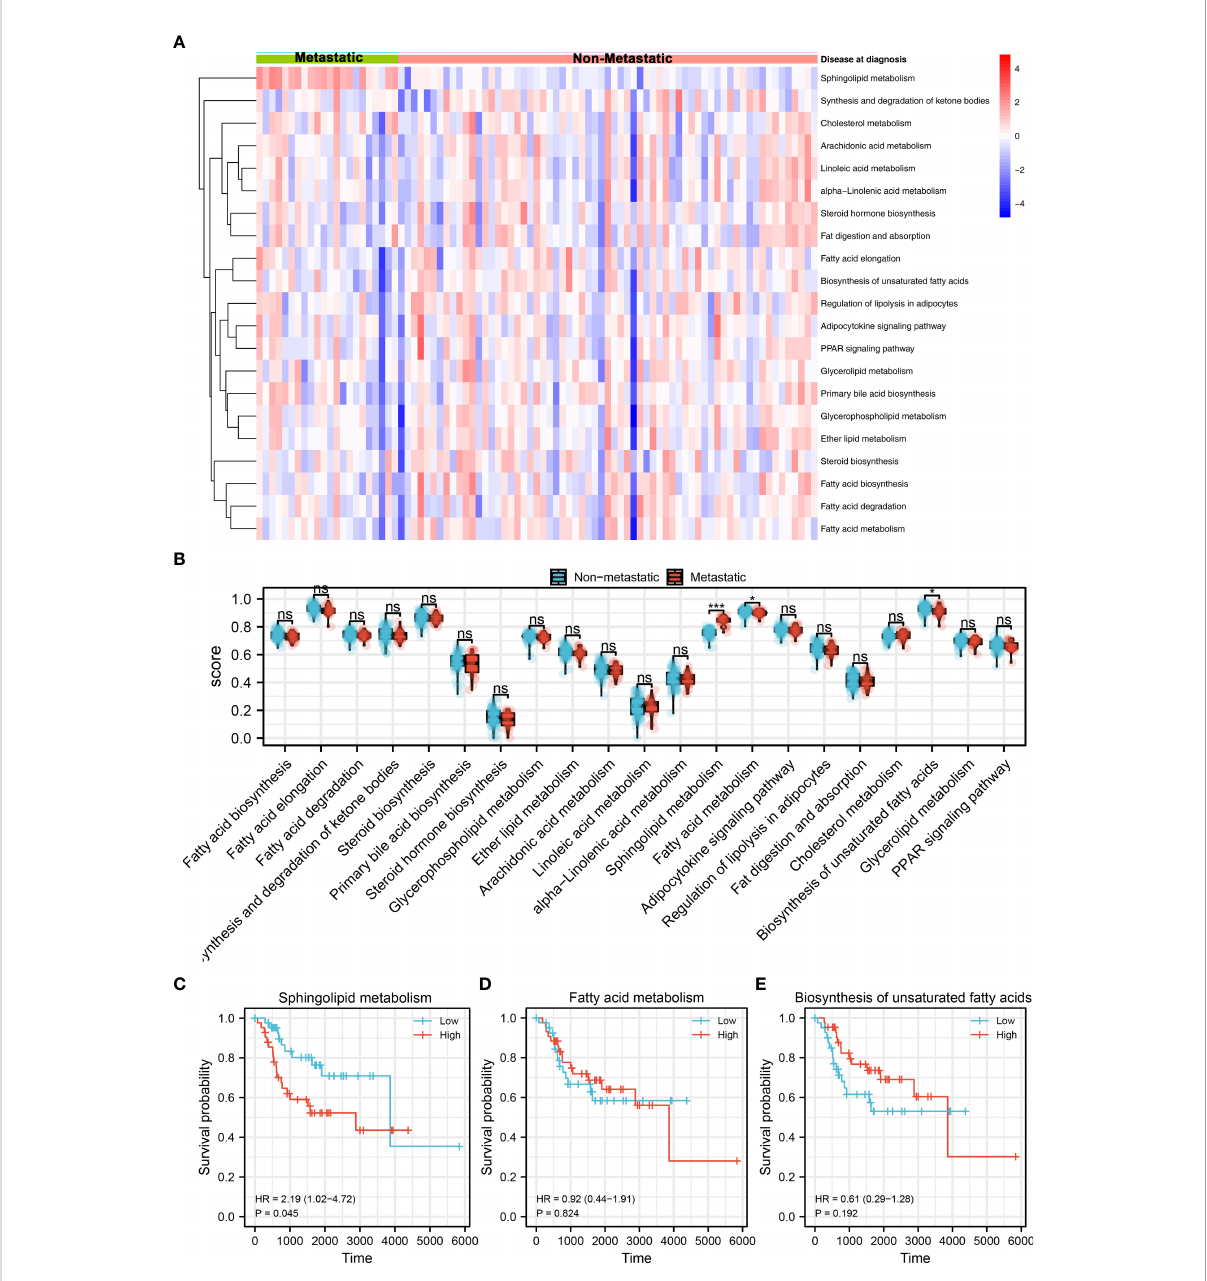
FIGURE 1 Identi fi cation of sphingolipid metabolism in OS Notes: (A) : A total of 21 metabolism terms were quanti fi ed using the ssGSEA algorithm, which was shown in a heatmap; (B) : The pathway activity of 21 metabolism terms in metastatic and non- metastatic OS, in which fatty acid metabolism and biosynthesis of unsaturated fatty acids were downregulated, while the sphingolipid metabolism was upregulated in the metastatic OS; (C) : Kaplan-Meier survival curve of overall survival between high and low sphingolipid metabolism patients; (D) : Kaplan-Meier survival curve of overall survival between high and low fatty acid metabolism patients; (E) : Kaplan-Meier survival curve of overall survival between high and low biosynthesis of unsaturated fatty acids patients. ns, P < 0.05. *P < 0.05; ***P <